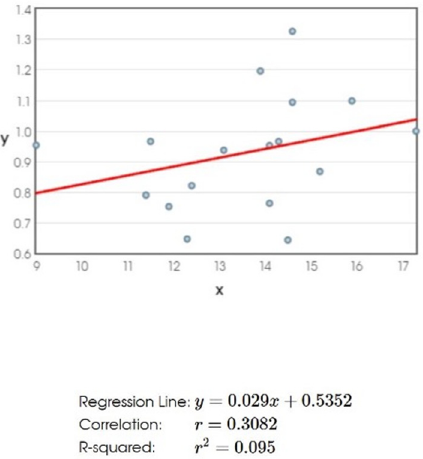
Figure 2. Correlation between initial ST thickness in the maxilla (x axis) and the relation between postoperative soft and hard tissue movement (y axis)—cases of maxillary advancement of 5 mm or less (N = 16, p = 0.28).